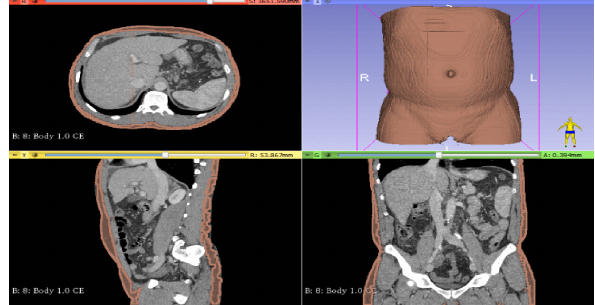
Figure 6: Semi-Automated segmentation for abdomen in 3D Slicer